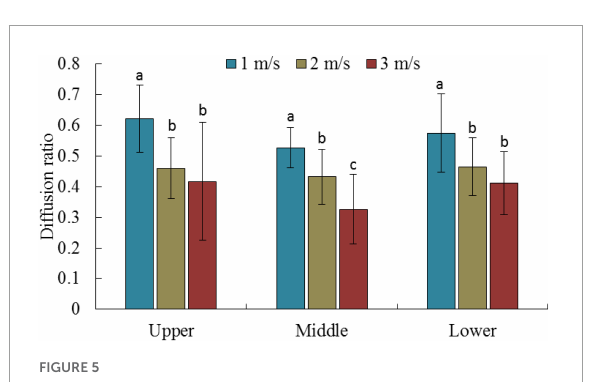
FIGURE5 Mean diffusion ratio for different canopy locations and flight velocity. Letters indicate significant